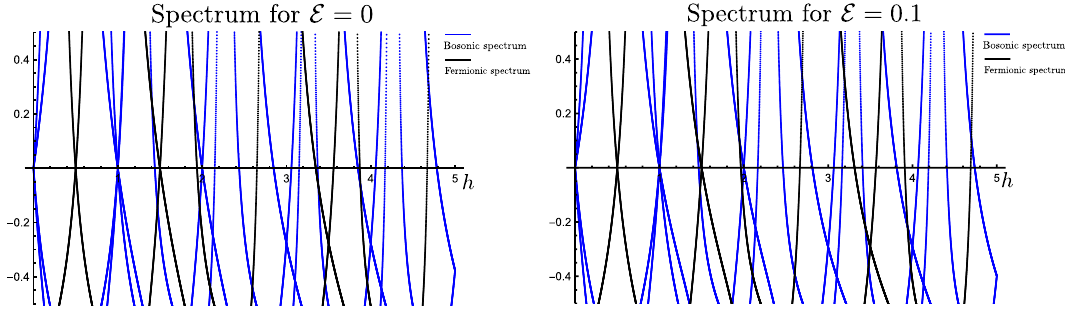
Figure 14 . The bilinear spectrum for U (1) neutral sectors for E = 0 and 0 . 1 where each intersection with the horizontal axis signifies an operator with dimension corresponding to the location of the intersection. The blue curve is bosonic and the black curve is fermionic. All fermionic operators are in fact doubly degenerate due to K and ¯ K having identical spectrum. In f f addition, the presence of pairs of lines comes from the spurious doubling of the spectrum due to unphysical local symmetries. Accounting for the unphysical modes, the E = 0 spectrum possesses the N = 2 Schwarzian multiplet with two h = 3 / 2 modes. Turning on the chemical potential leads to an IR theory with spontaneously broken supersymmetry. While the spectrum still organizes into multiplets, the 3 / 2 modes are no longer protected.